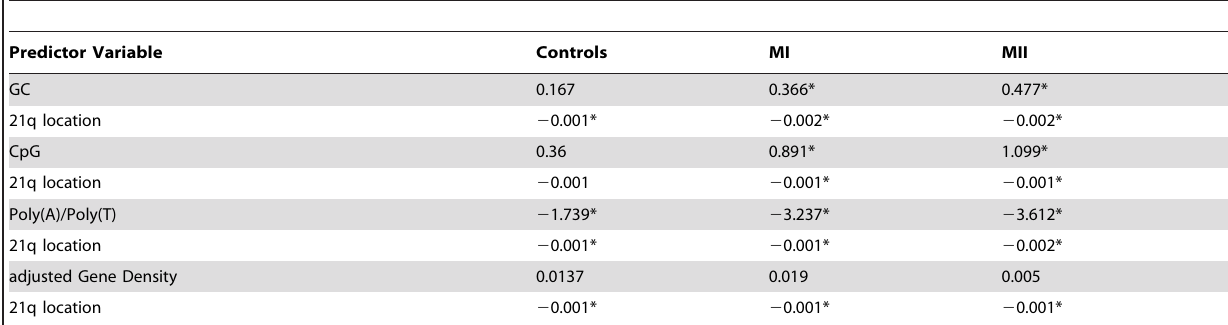
Table 3. Values of slopes/beta coefficients for GC, CpG, PolyAT and gene density for the proximal recombinant of a double recombinant event stratified by meiotic outcome group.